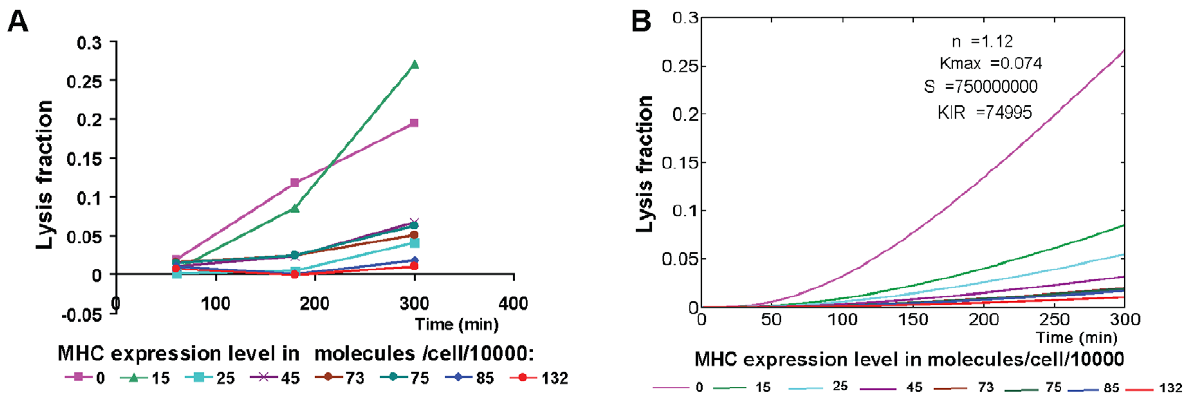
Figure 5. The kinetics of NK cell activation. A) Experimental results. The percent of lysed target cells expressing different amounts of MHC class I was determined by radioactive release assays, after 1, 3 or 5 hrs of co-incubation. B) Mathematical model – simulation